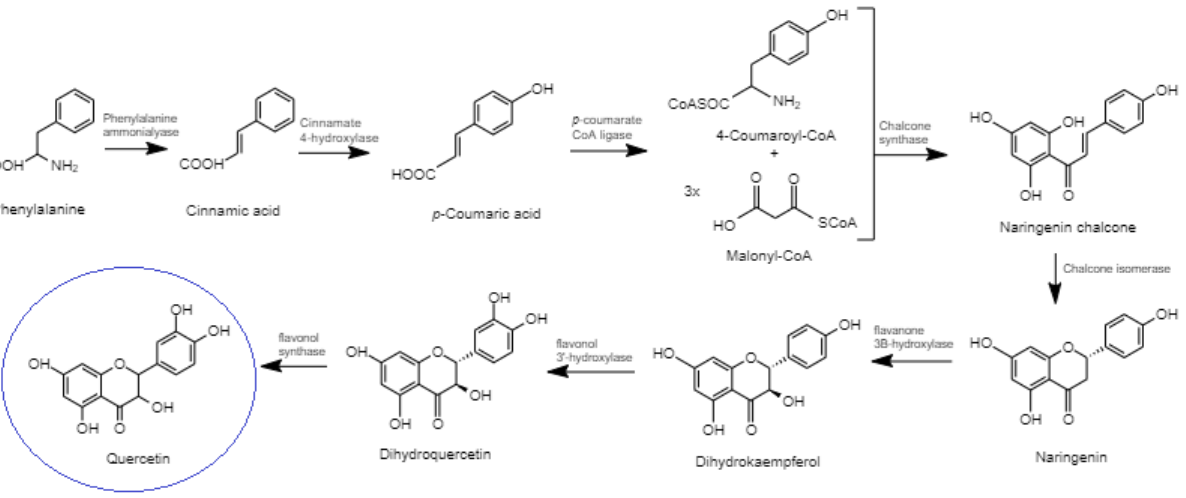
Figure 3. Quercetin biosynthesis.